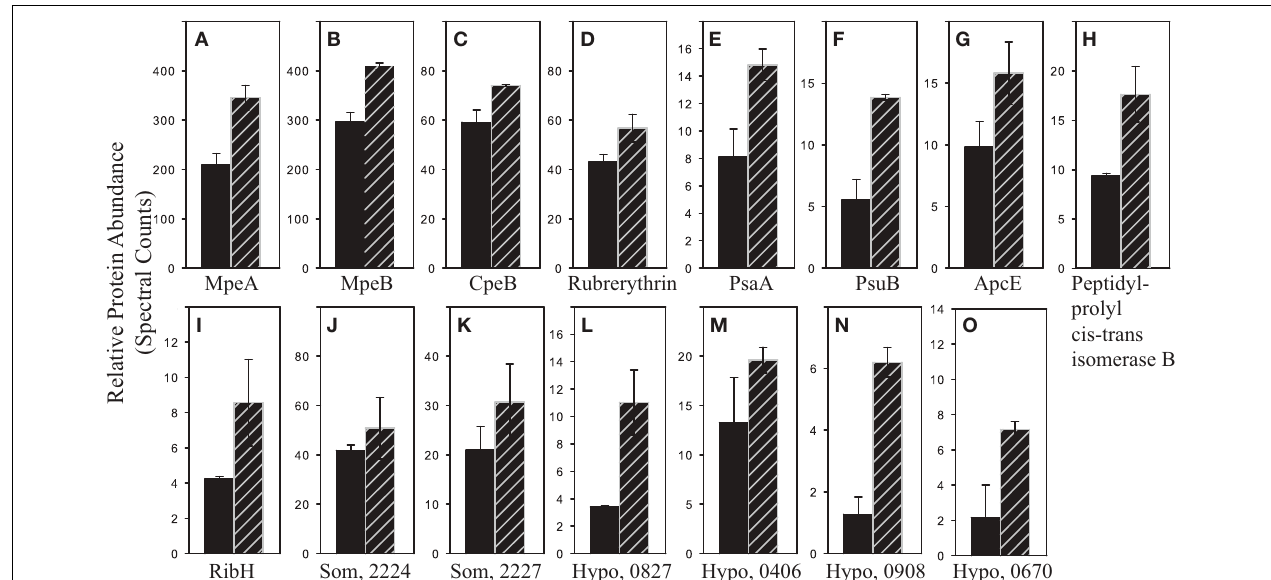
FIGURE 8 | Proteins more abundant with short-term cadmium addition. Relative protein abundances of proteins two-fold or more greater in abundance and/or statistically different by Fisher’s Exact Test in the no Zn/65 μ M PO 43 − / + 4.4 pM Cd 2 + (hatched bars) compared to the no Zn/65 μ M PO 43 − treatments (solid bars). (A) SYNW2009 C-phycoerythrin class II, α chain, (B) SYNW2008 C-phycoerythrinclassII, β chain, (C) SYNW2017C-phycoerythrinclassI, β chain, (D) SYNW2369 rubrerythrin, (E) SYNW2124 PSI P700 (PsaA), (F) SYNW3191